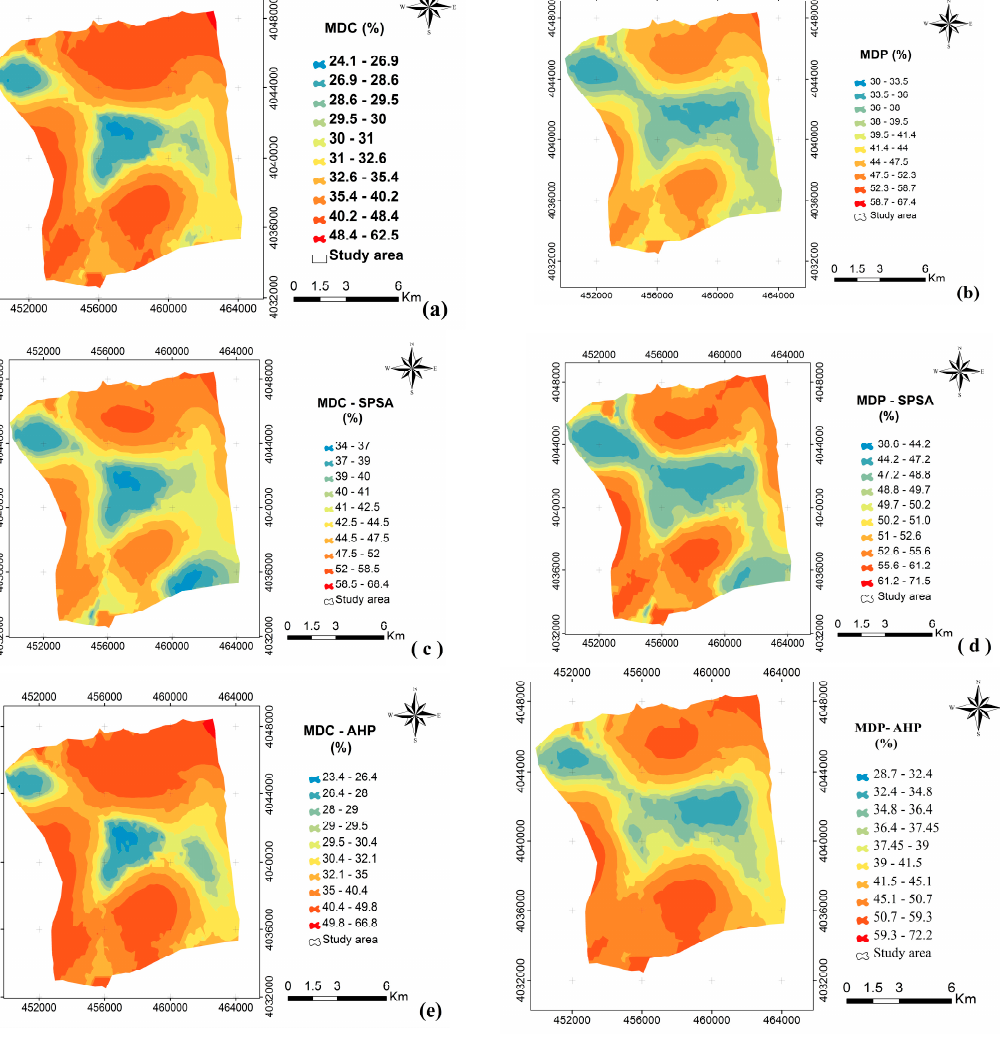
Figure 7. Vulnerability maps ( a – f ) based on various weighting factor methods (MPC, MDP, MDC– SPSA, MDP–SPSA, MDC–AHP and